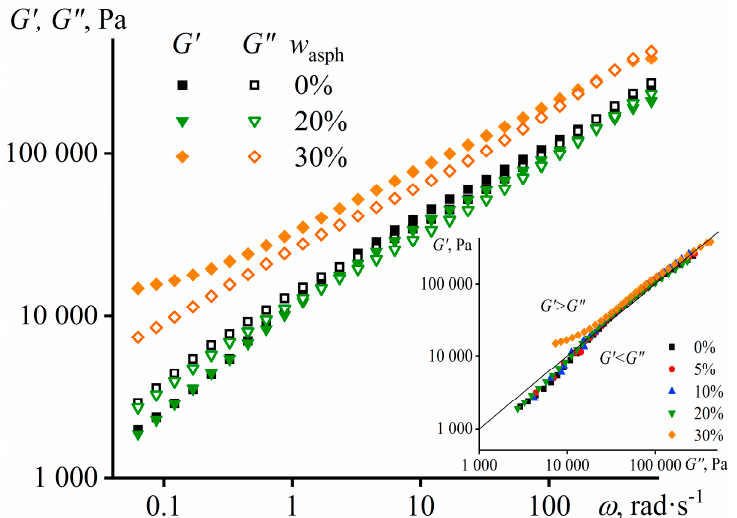
Figure 5. The dependences of storage and loss moduli on angular frequency for PIB and its mixtures containing a different mass fraction of asphaltenes at 25 °C. The insert shows the same dependences but as Cole–Cole diagrams.